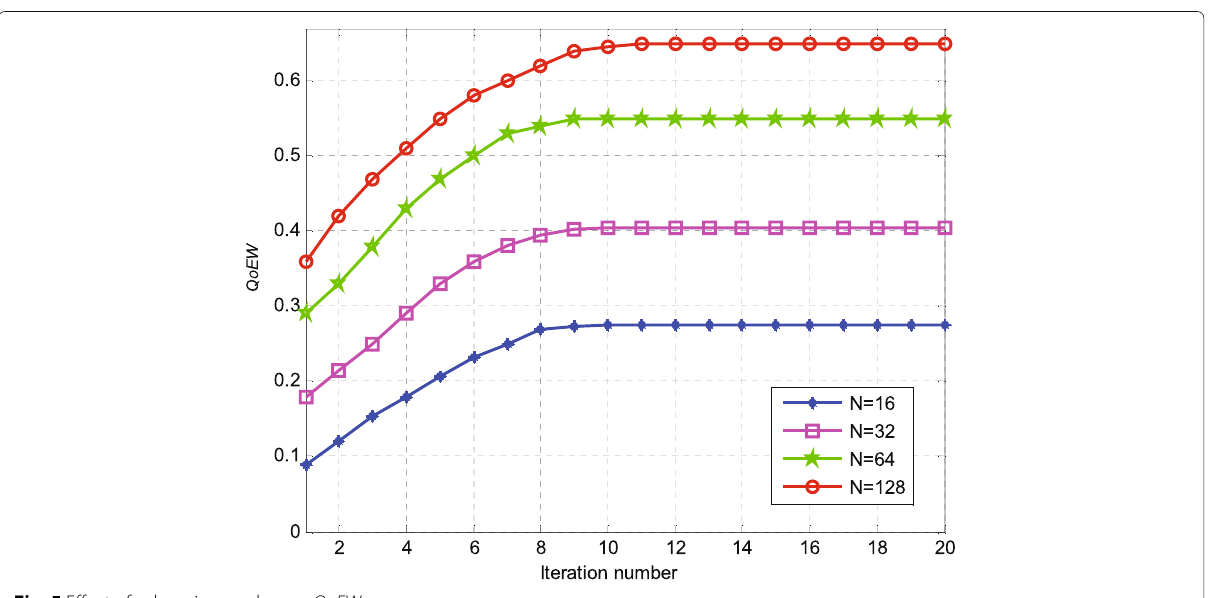
Fig. 5 Effect of subcarrier number on QoEW